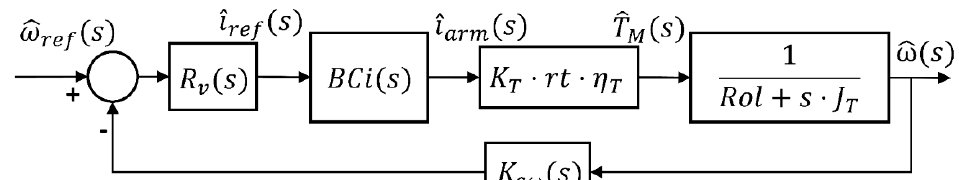
Table 1. Motor-vehicle compensators data.